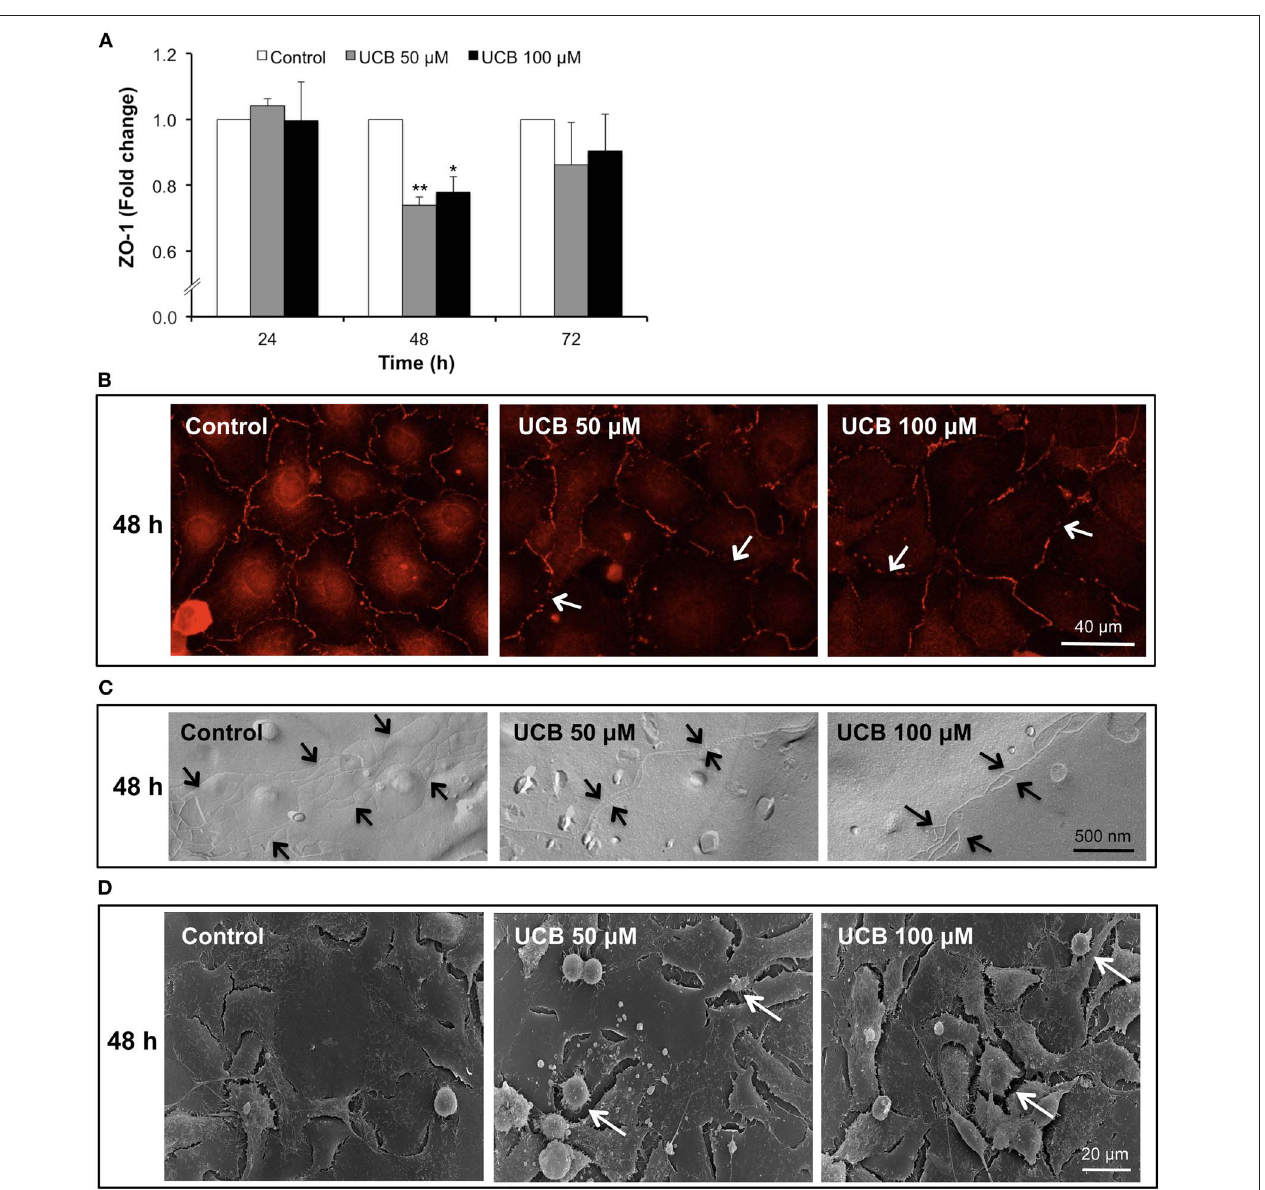
FIGURE 5 | Interaction of UCB with the HBMEC monolayer determines a later down-regulation of ZO-1 protein. HBMEC line was incubated without (control) or with 50 or 100 μ M UCB, in the presence of 100 μ M HSA, for the indicated incubation periods. Total fluorescence of ZO-1 is shown as fold change from respective control (A) . Representative results, showing loss of ZO-1 staining (arrows), after a 48h period of incubation are shown (B) . UCB